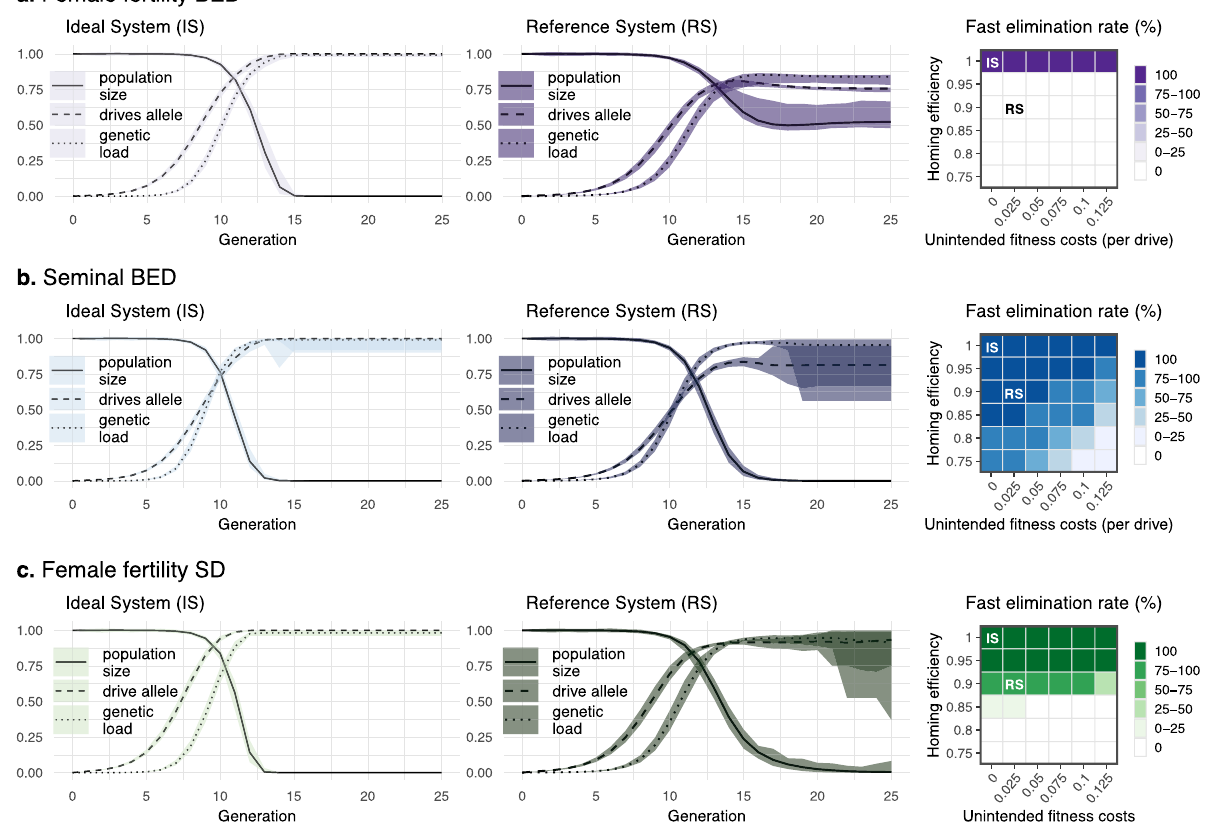
Figure 3. Suppression potential of ffBED ( a ), sBED ( b ), and ffSD ( c ). Left: population size (relative to the initial population size), drive(s) allele frequency, and genetic load are shown across the first 25 generations for each design using ideal and reference drive parameters. Lines represent the 100-simulations mean value while the colored envelopes stand for the maximum and minimum values. For BED designs, frequencies of the two drives were averaged. Right: fast elimination rate (the percentage of simulations where the population was eliminated within 36 generations) is shown for a combined space of Homing efficiency and Unintended fitness costs ( Unintended reproductive cost and Unintended viability cost ). Resistance allele formation was assumed to be half the complement of Homing efficiency (e.g., if Homing efficiency is 0.8, Resistance allele formation is